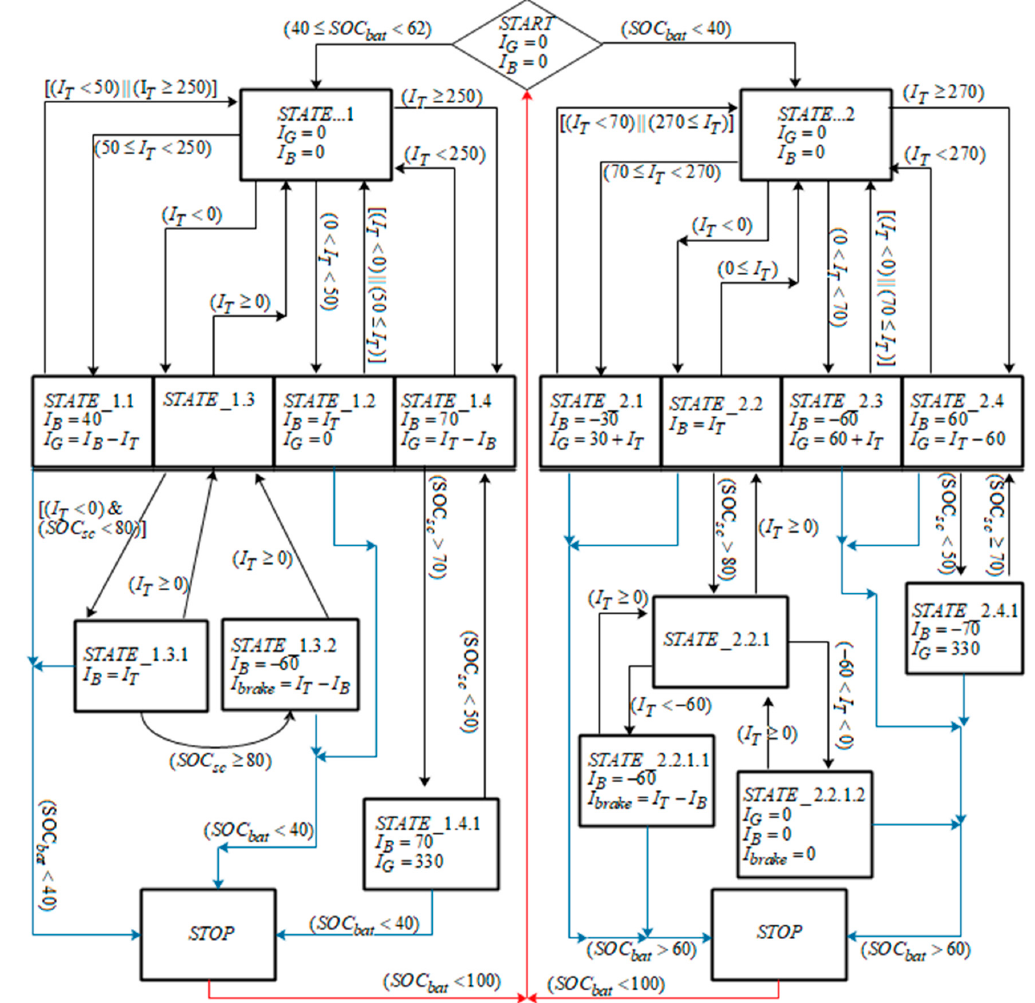
Figure 10. State Machine Controller.